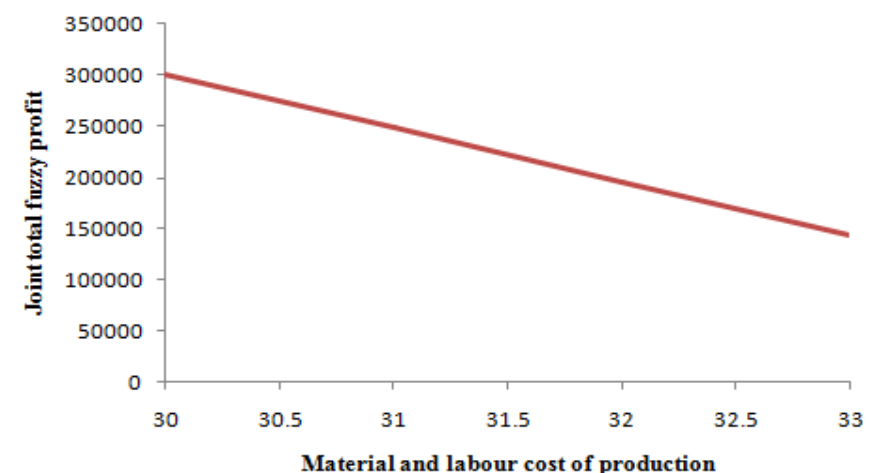
Figure 16. Material and labor cost vs. the joint total fuzzy profit.